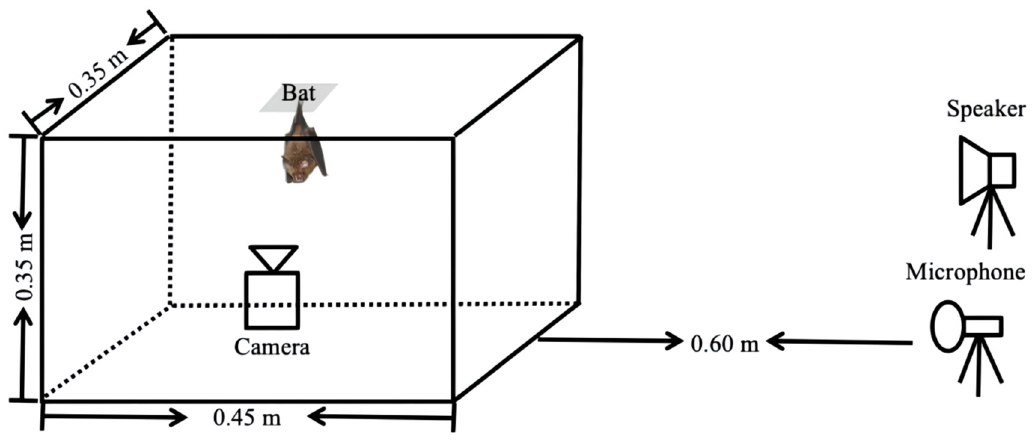
Figure 4. Experimental set-up of the habituation-dishabituation experiments.